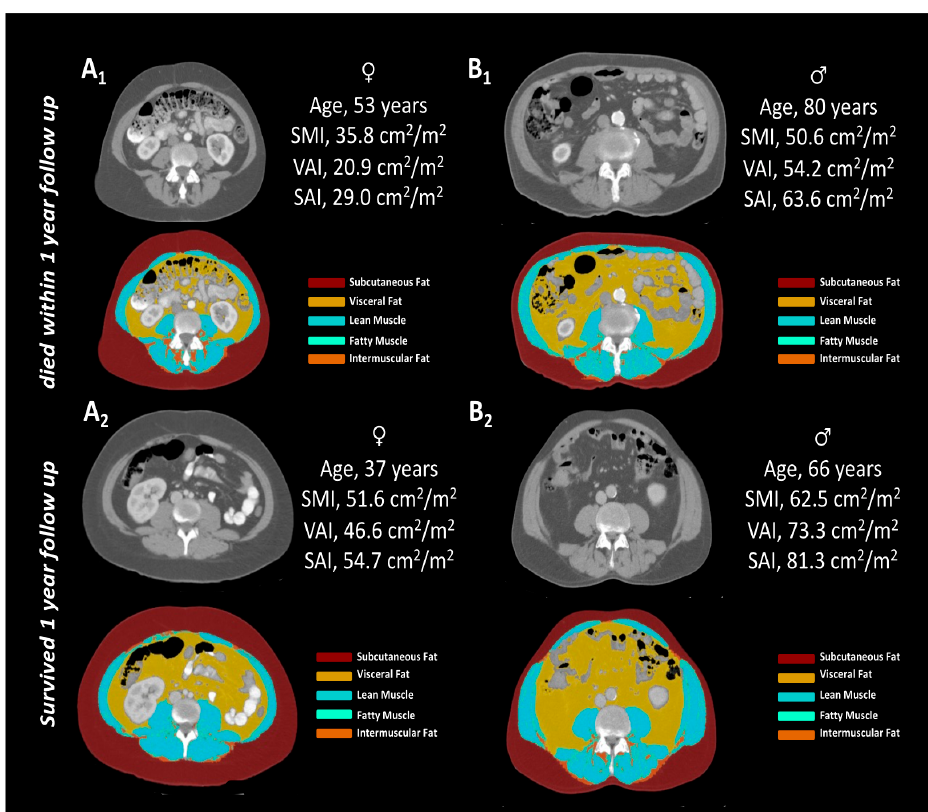
Figure 1. Exemplary patients from the study population. Female ( A1 , A2 ) and male ( B1 , B2 ) patients who passed away ( A1 , B1 ) or were alive ( A2 , B2 ) 1 year after initial staging CT for treatment initiation of immune checkpoint inhibitor therapy alongside obtained body composition metrics (SMI, VAI, SAI). Abbreviations: SMI, skeletal muscle index; VAI, visceral adipose tissue index; SAI, subcutaneous adipose tissue index.